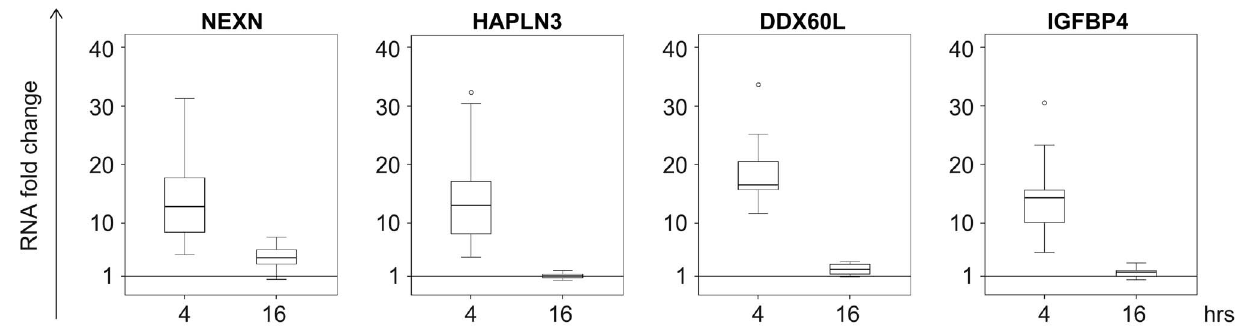
Figure 5. NEXN , DDX60L , IGFBP4 and HAPLN3 respond transiently to IFN- b . The expression levels of NEXN , DDX60L , IGFBP4 and HAPLN3 in LCLs were analysed by real time RT-PCR analysis after 4 or 16 hours of exposure to 100 u/ml IFN- b . Data is presented as a box plot of the 25 th and 75 th